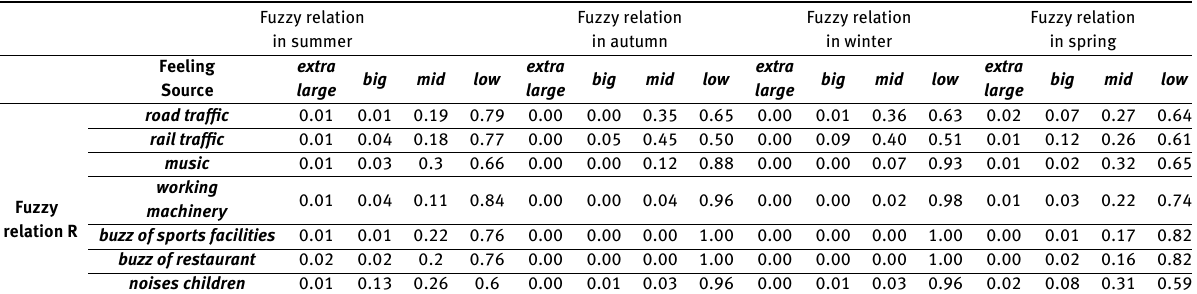
Table 2: Fuzzy relations in each seasons.